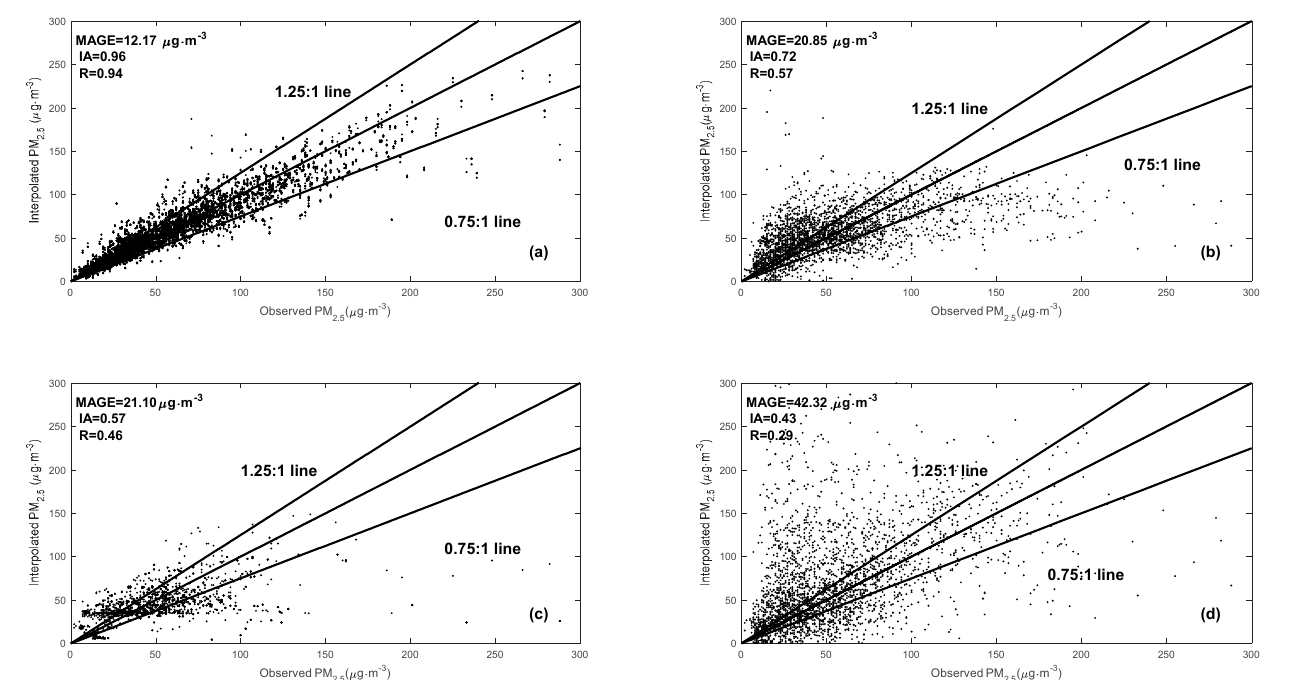
Figure 5. Scatter plots and performance of different methods for the 8-fold cross-validation experiments on 17–20 May 2014: ( a ) Performance of the 8-fold cross-validation DCIM simulations in the interpolated samples, ( b ) Performance of the 8-fold cross-validation DCIM simulations in the checked samples, ( c ) Performance of the 8-fold cross-validation kriging simulations in the checked samples, ( d ) Performance of the 8-fold cross-validation COPF simulations in the checked